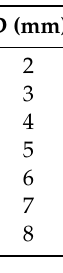
Table 3. Group 3: Constant width (24 mm) with variable center